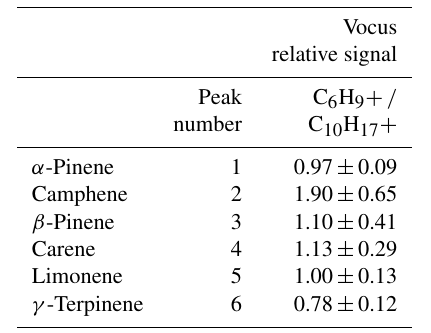
Table 3. Relative signals of ions detected in the Vocus,